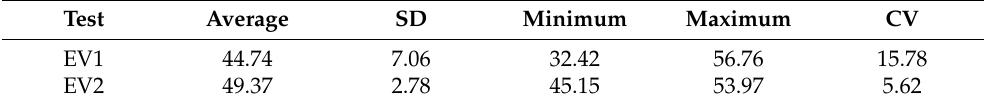
Table 9. The average value of the percentage distribution of the weight on the right leg.